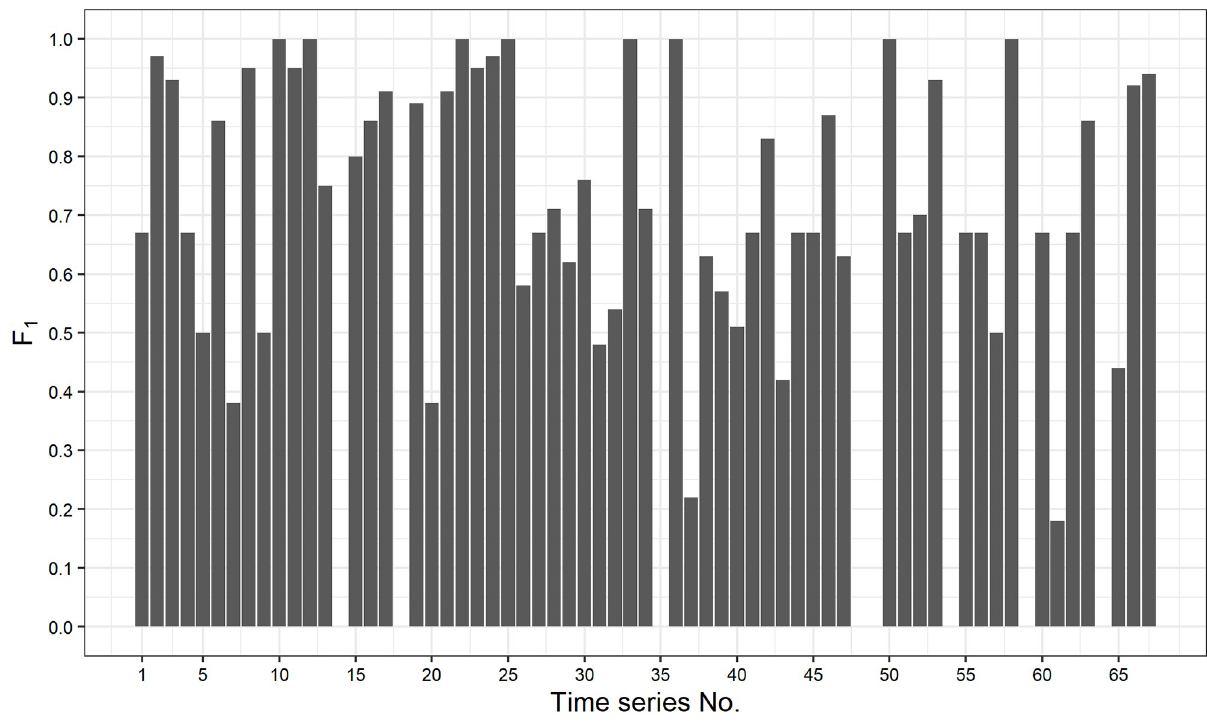
Fig 2. Best F 1 scores on all A1 benchmark time